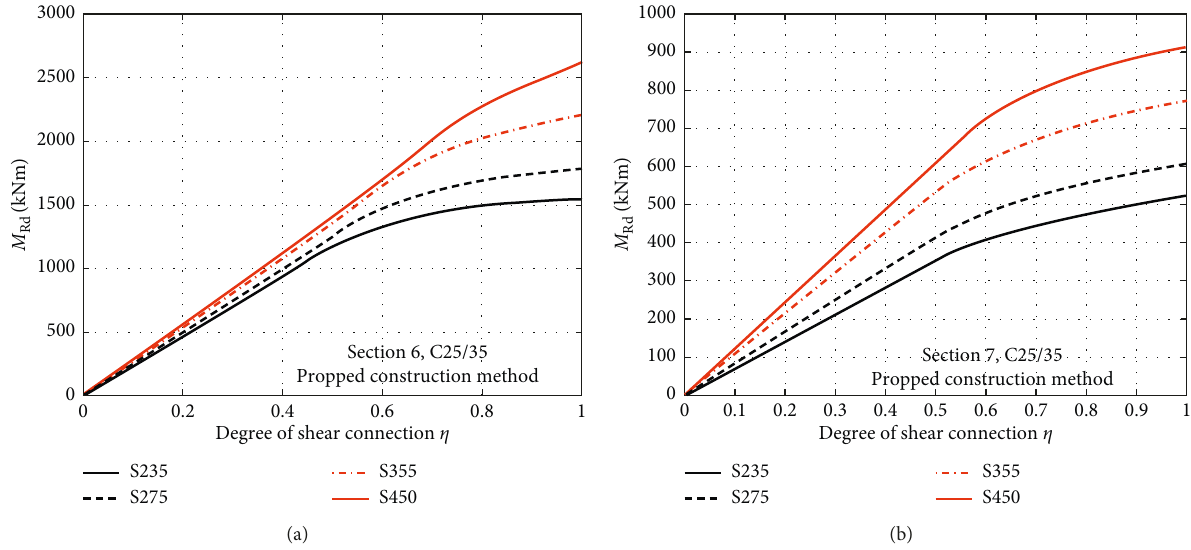
Figure 15: Effect of variation of class of steel on resisting bending moment-degree of shear connection relation (propped construction method). (a) Section 6 C25/35 and (b) Section 7 C25/35.